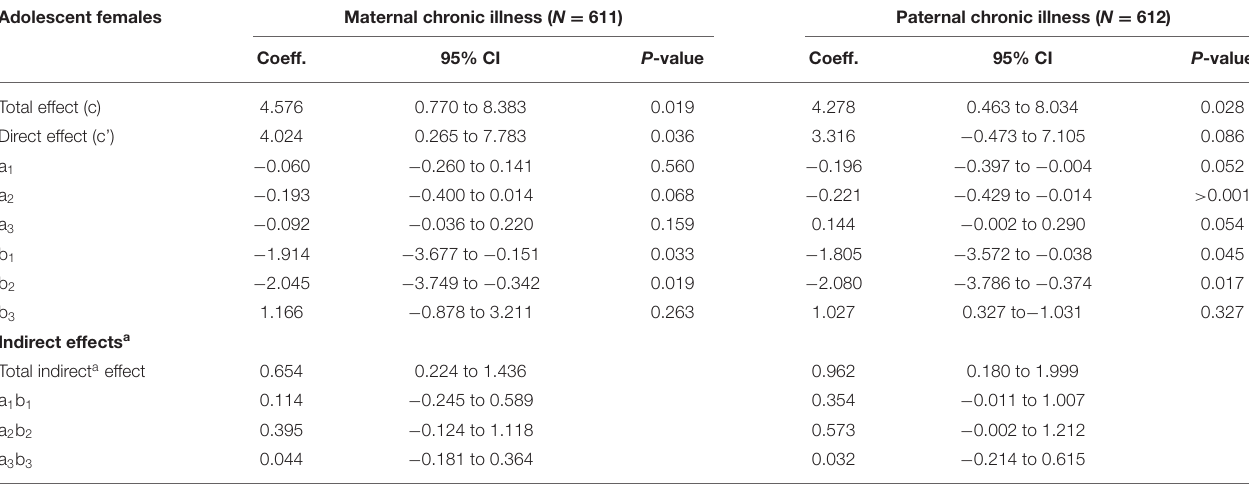
TABLE 4 | Separate analyses for female adolescents: Path coefficients for the parallel mediation models, separate models for maternal and paternal chronic illness. Adolescent females Maternal chronic illness ( N = 611) Paternal chronic illness ( N = 612) Coeff. 95% CI P -value Coeff. 95% CI P -value